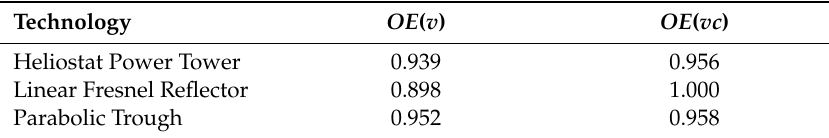
Table 7. Average input-based e ffi ciencies: three technologies.